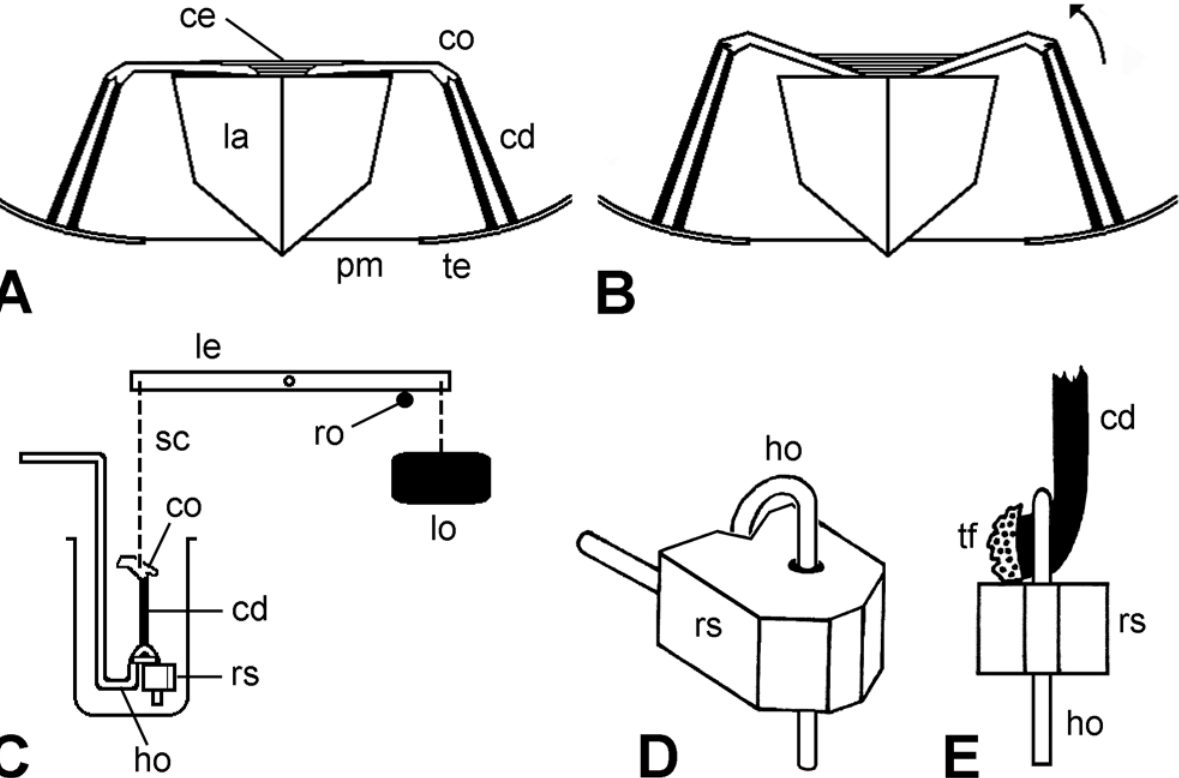
Fig 2. Compass depressors of P . lividus and experimental set-up; not to scale. (A,B) Diagrammatic lateral views of components associated with the lantern (la) of P . lividus that are relevant to this investigation. Two compasses (co) and their paired compass depressors (cd) are shown. In A the compasses are fully depressed. Contraction of the compass elevator muscles (ce) effects upwards rotation of the compasses, as shown in B (arrow). pm, peristomial membrane; te, circumoral region of the test. (C) Diagrammatic lateral view of experimental set-up used for creep tests on isolated CDs. ho, hook; le, isotonic lever; lo, load; ro, horizontal rod (shown as transverse section); rs, rubber stop; sc, silver chain. (D) Oblique view of the device designed to grip the test end of each CD. The test fragment to which the CD was attached was trapped in the loop of the wire hook (ho) by a rubber stop (rs) that fitted tightly round the vertical extremity of the hook, but could be slid up and down, as required. (E) Front view of the latter device with a CD in place. tf, test fragment.